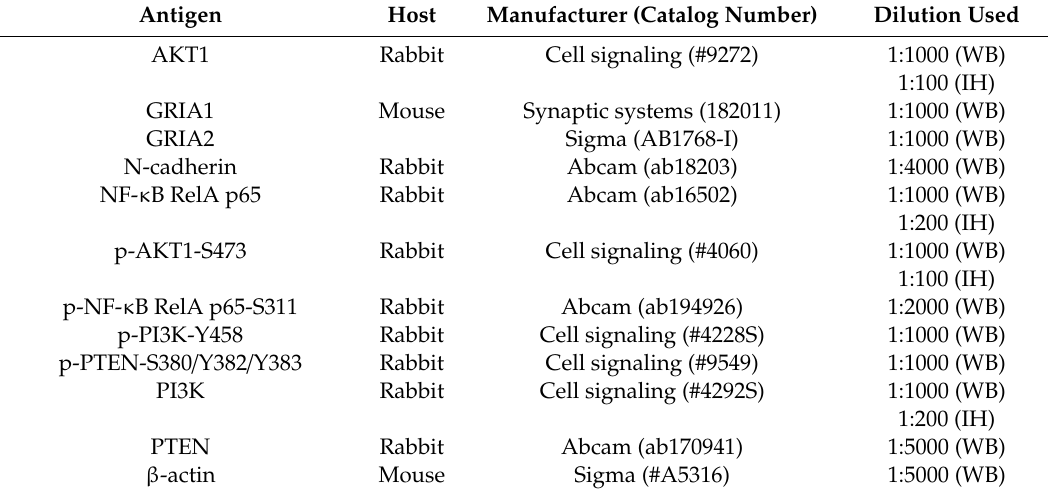
Table 1. Primary antibodies used in the present study.